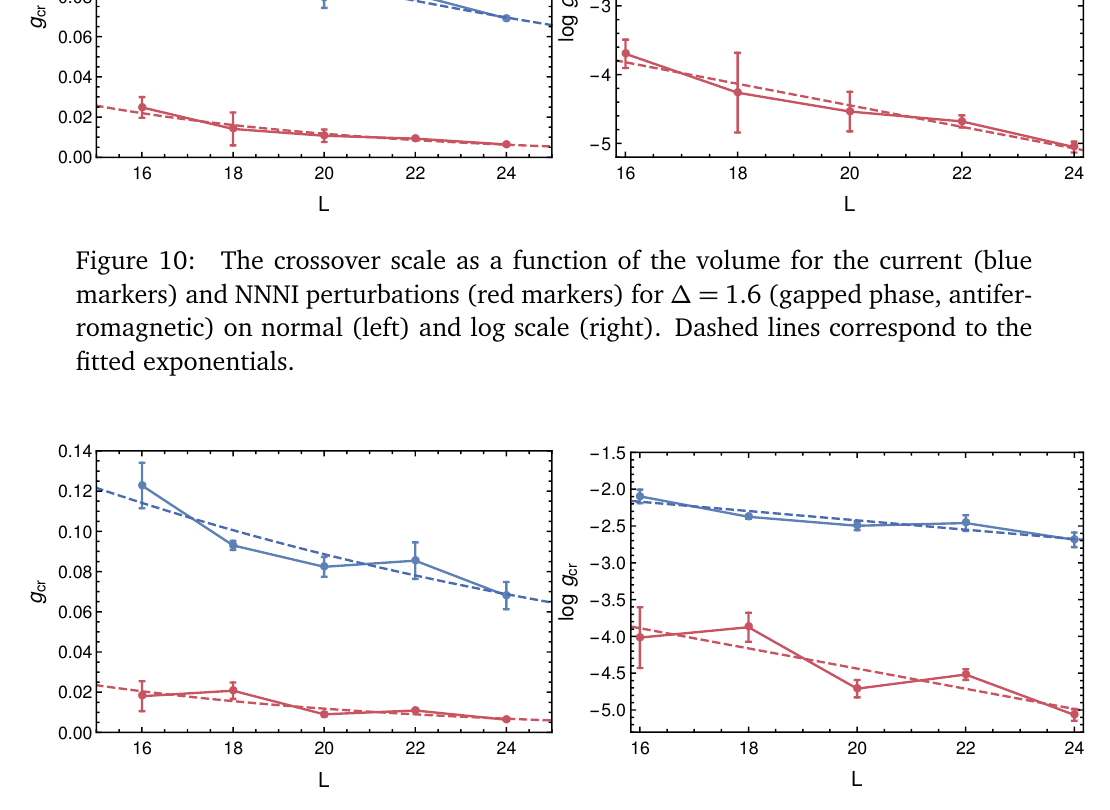
Figure 11: The crossover scale as a function of the volume for the current (blue markers) and NNNI perturbations (red markers) for ∆ = − 1.6 (gapped phase, fer- romagnetic) on normal (left) and log scale (right). Dashed lines correspond to the fitted